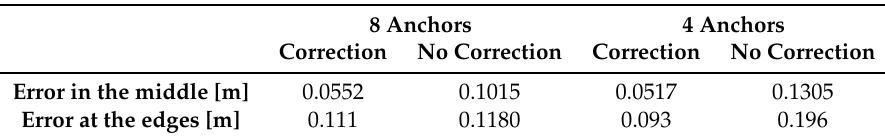
Table 3. Estimation error for radio tags positioned in the middle of the area covered by the anchor units vs. the edges of such area when using eight vs. four anchor